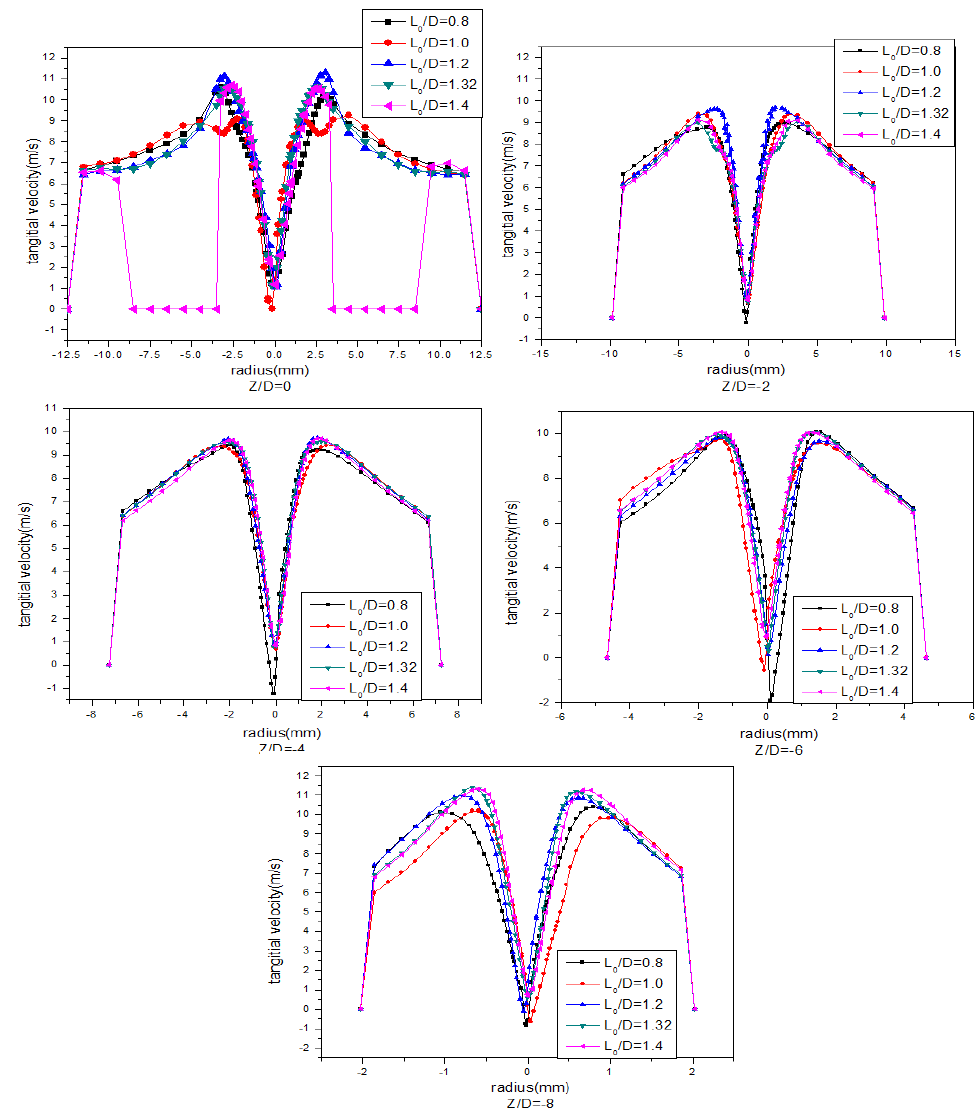
Figure 8. Tangential velocity comparative analysis chart of mini-hydrocycloness with different vortex finder depth.